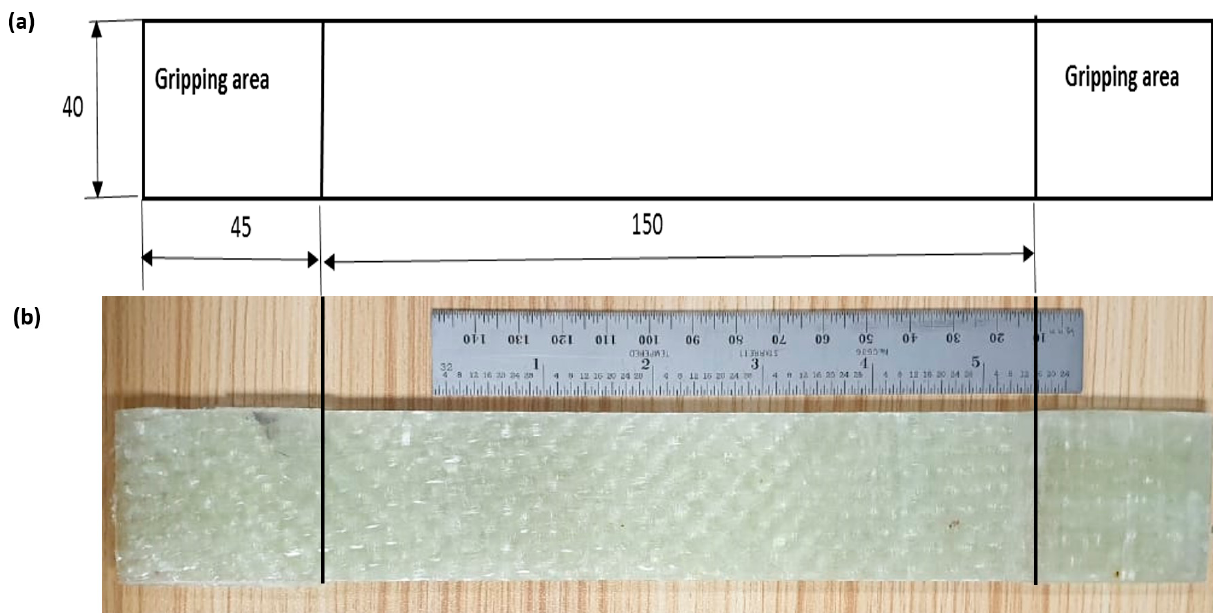
Figure 4. Tensile test specimen geometry; ( a ) Schematic drawing (dimensions in mm); ( b ) Real image.